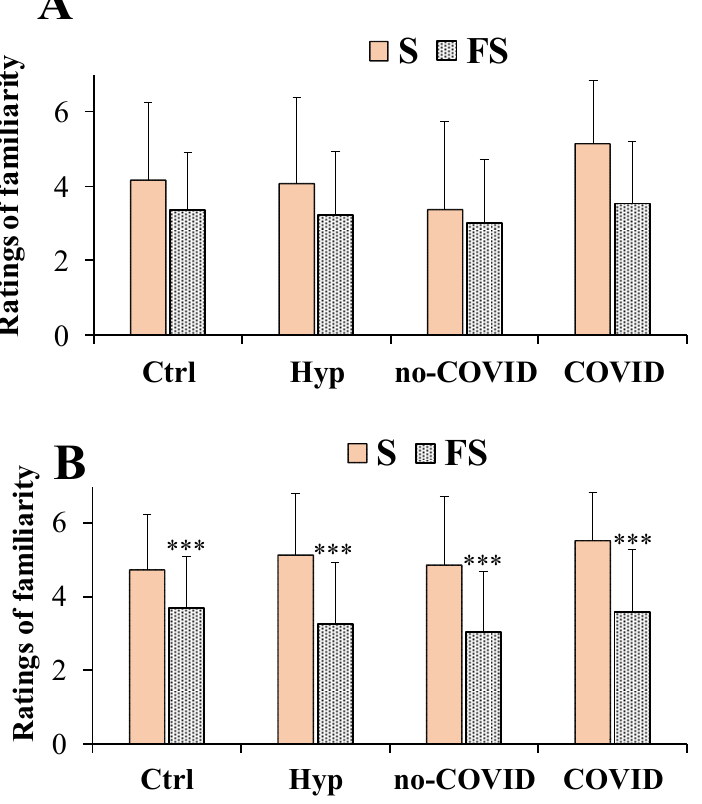
Figure 4. Ratings of familiarity dimension measured in total patients with hyposmia (Hyp, n = 57), subjects without (no-COVID, n = 34) or with (COVID, n = 23) post-acute coronavirus syndrome compared to healthy controls (Ctrl, n = 91), in response to saline solutions obtained with pure sea salt (S) and flavored salts (FS) at the concentrations of 0.1 g/mL (high dose) ( A ) and 0.04 g/mL (low dose) ( B ). Data are presented as mean values and standard deviations. For FS, each value of the taste dimensions was obtained as the mean of participant responses to the three different commercial FS samples. Significant differences among the four different groups of subjects (as between factors) in relation to type of salt (S and FS as within factor) were calculated using two-way repeated measures ANOVA. *** = p < 0.001 FS versus S.